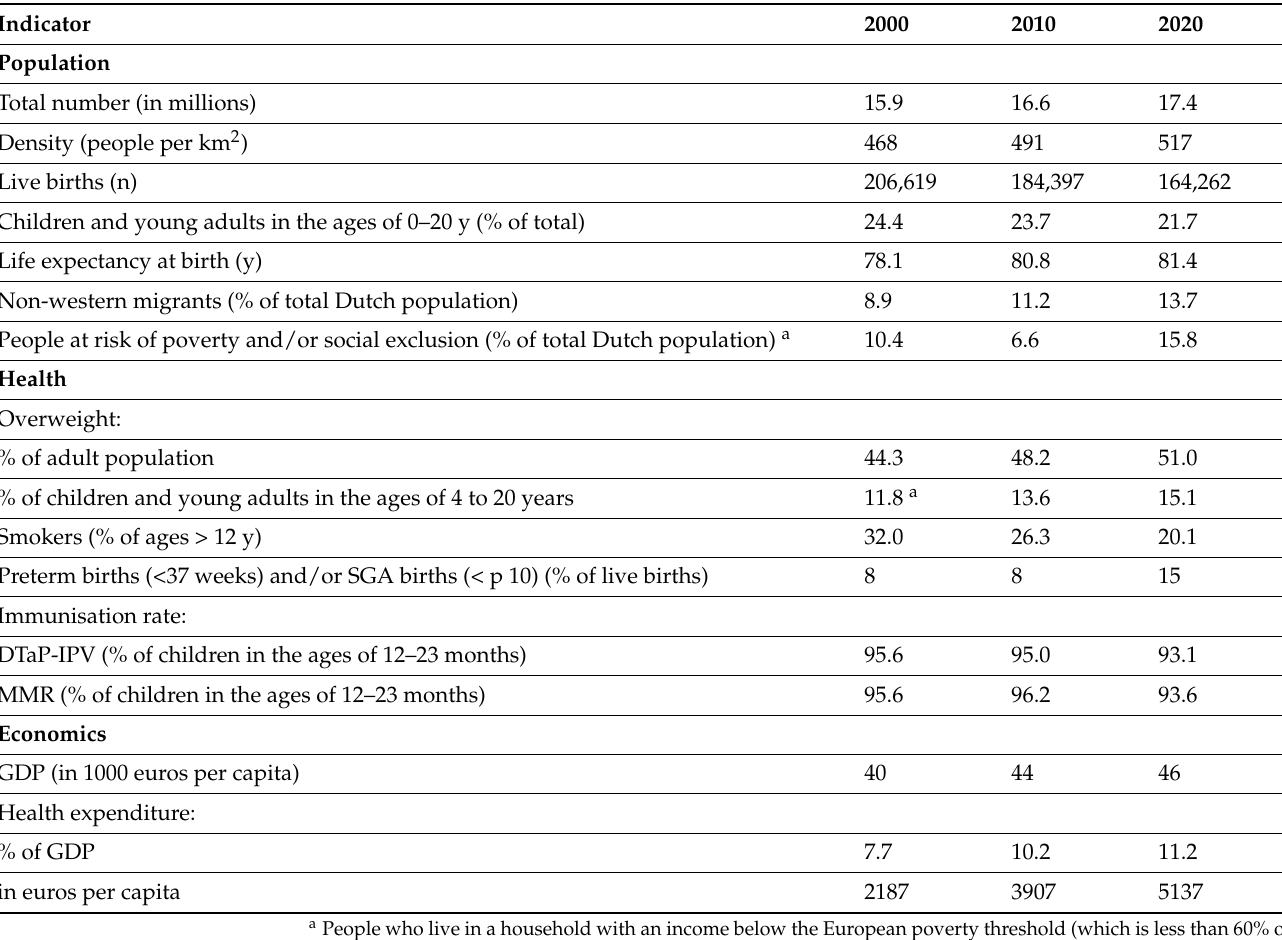
Table 1. The Netherlands: population, health, and economic characteristics, 2000–2020